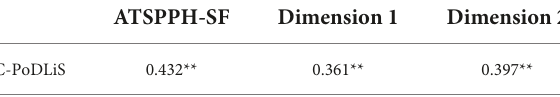
TABLE 6 Correlations of the C-PoDLiS and ATSPPH-SF